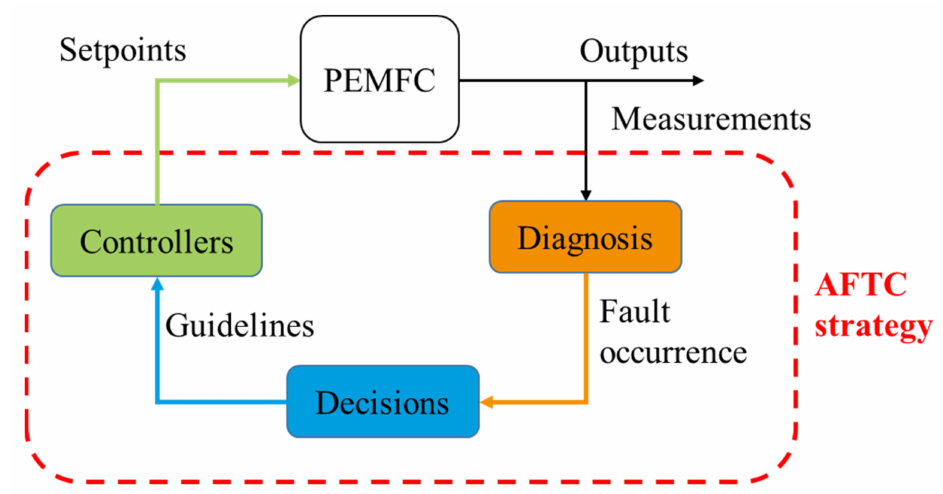
Figure 9. Iterative AFTC strategy.